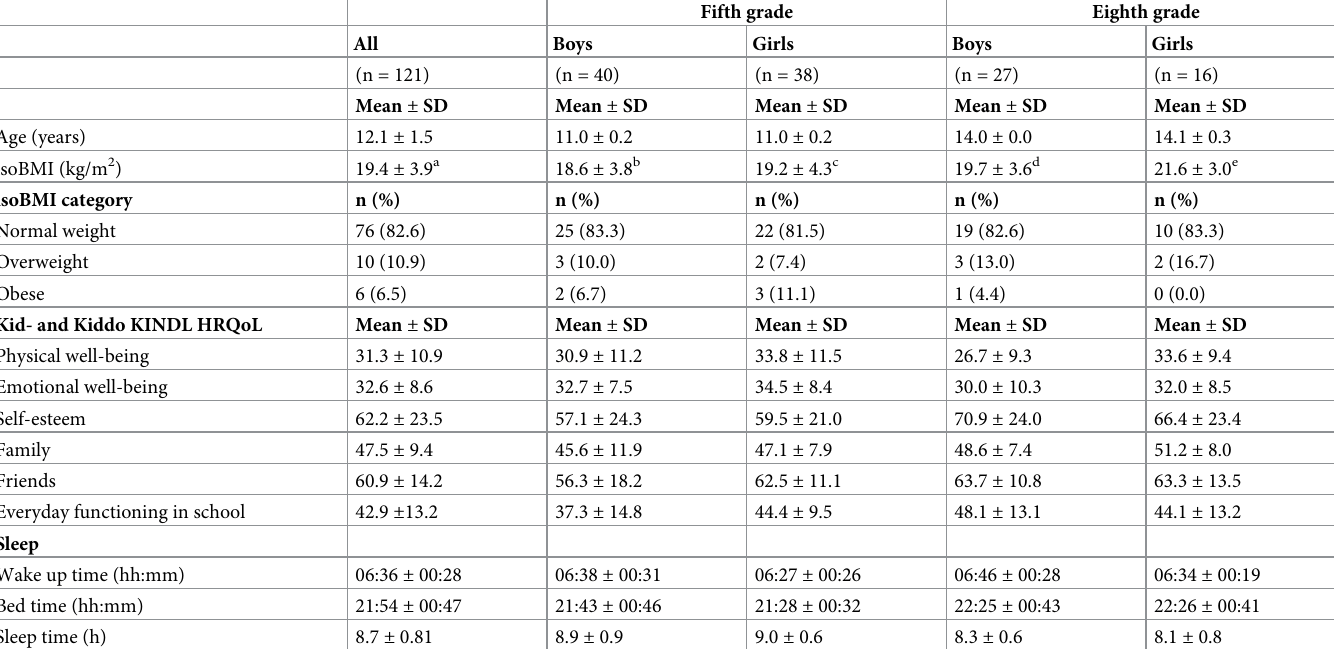
Table 1. Characteristics of the children and adolescents, all and stratified by grade and